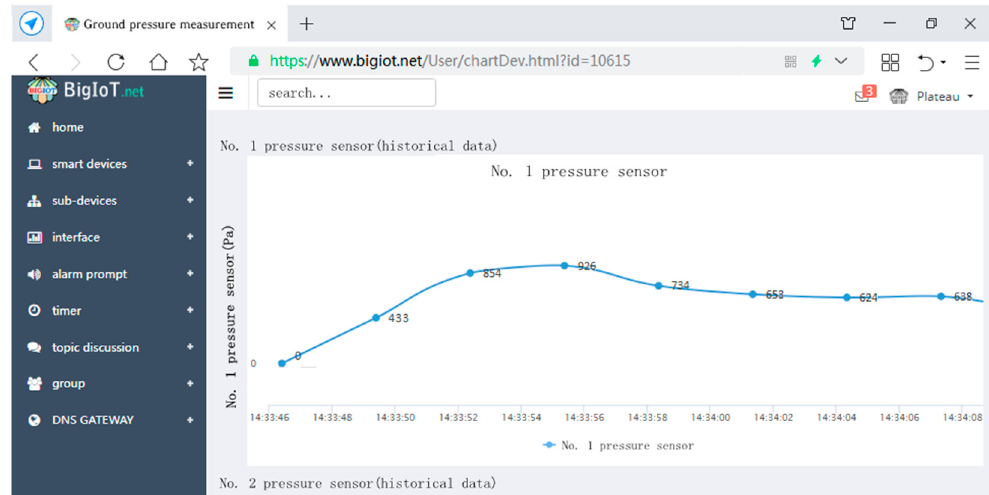
Figure 9. Internet of things measurement system—computer terminal.